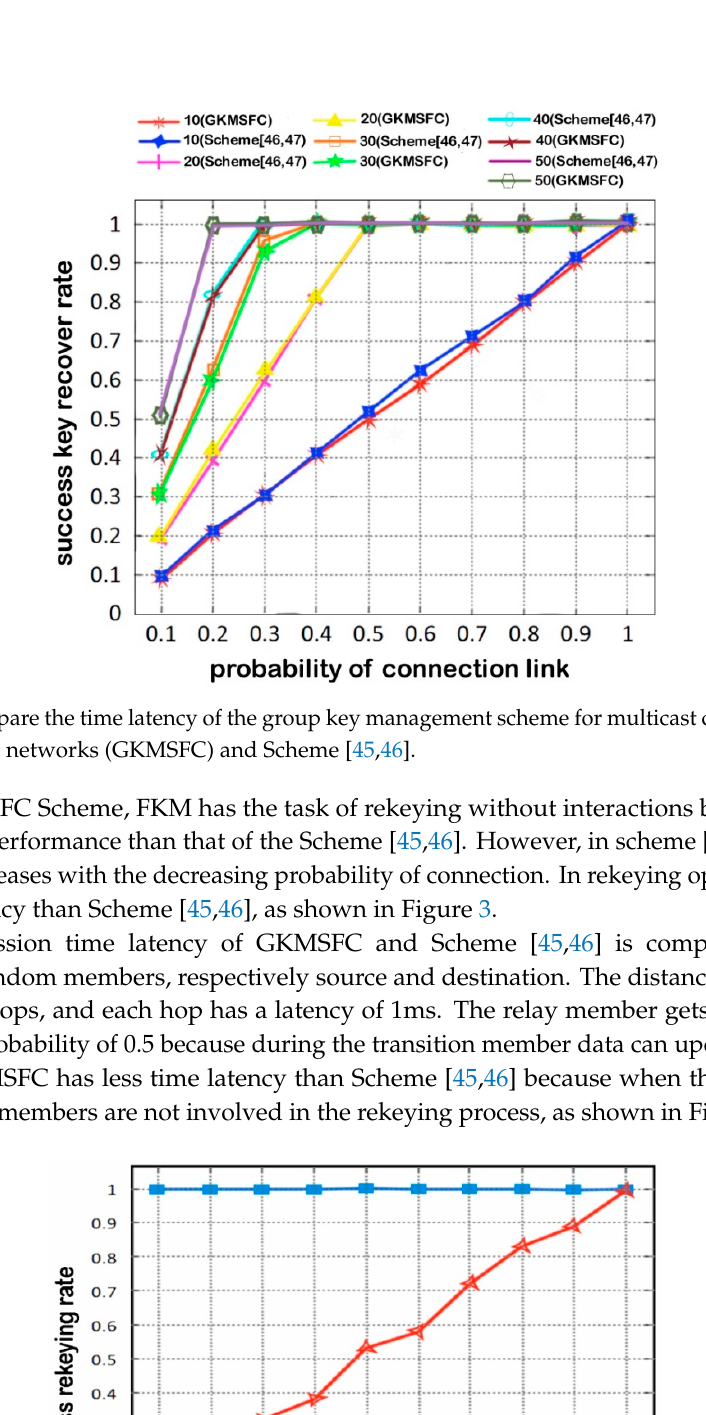
Figure 5. Compare time latency between GKMSFC and Scheme [45,46]. 7. Conclusions Based on the common secret product of the cryptography threshold and the bilinear pairs, we have proposed GKMSFC based scheme, which is a profile of a key management diagram that has better performance. The independence of the key is met by the decryption keys, with the advantage of an encryption key that corresponds to multi-decryption keys, including two components, fog computing and the end-users, respectively. In the rekeying operation, the key segments are divided into two elements, one is kept secret by FMK, where it can update the main key by its method. The other one is known by members which is unchanged, to help to improve the rekeying efficiency for time latency. The failure to update the decryption key of all remaining members would improve the cost of messaging and calculation. For the security aspect, because a different random value is chosen by the source in every process of decrypting, it is not possible to damage the decryption key, even an attacker has several key segments that exceed the threshold. GKMSFC can ensure the backward and forward security and can against the collusion attacks. Author Contributions: Methodology, M.T.D.; software, M.T.D.; formal analysis, H.X.; resources, H.X.; data curation, M.T.D.; writing—original draft preparation, M.T.D.; writing—review and editing, M.T.D. and H.X. All authors have read and agreed to the published version of the manuscript. Funding: This research was funded by the National Science Foundation Project of China with No. 61971032, 61931001, the Fundamental Research Funds for the Central Universities with No. FRF-BD-20-11A. Conflicts of Interest: The authors declare no conflict of interest.